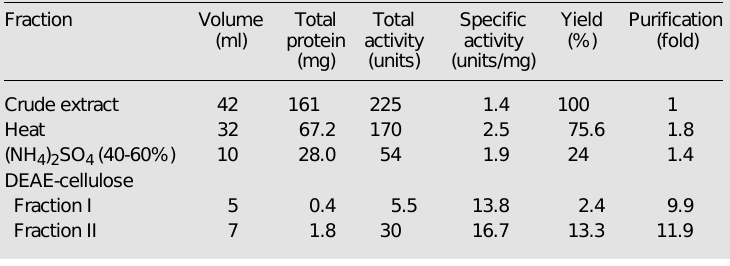
Table 1 - Partial purification of the constitutive alkaline phosphatases synthesized by the wild 74A strain of N. crassa grown in high-Pi medium at 30 o C, supplemented with 44 mM acetate as the carbon source and buffered at pH 5.4 with 100 mM sodium maleate.